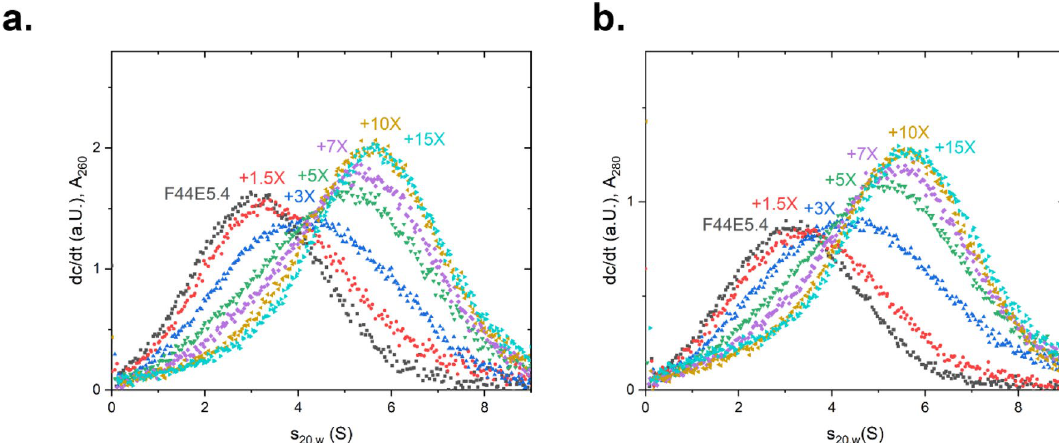
Figure 4. Analysis of interaction between promotor F44E5.4 and Hsf-1 DBD via titration in SV-AUC. HSF-1 DBD was titrated to the promoter F44E5.4 in concentrations ranging from a 0–15-fold excess. A shift to the right represents DNA-binding by the HSF-1 DBD. ( a ) dc/dt plot of the absorbance measured at 260 nm and for ( b ) at 280 nm at different concentrations of HSF-1 DBD, when added to 1.5 µM of HSE-containing